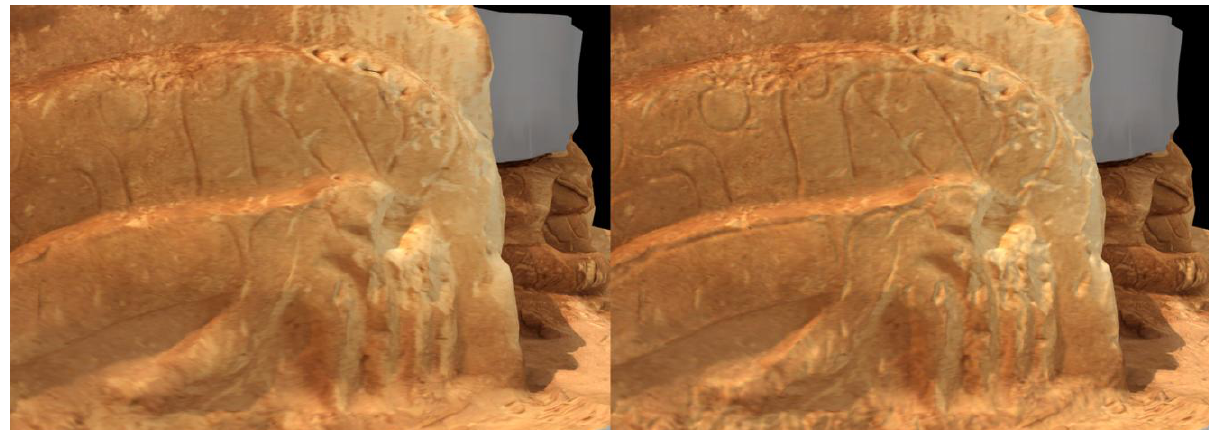
Figure 12: Comparison between results achieved with simple lightning (left) and normal mapping (right). Notice how shading of surfaces improves by using normal maps, but how the geometric detail of the model remains